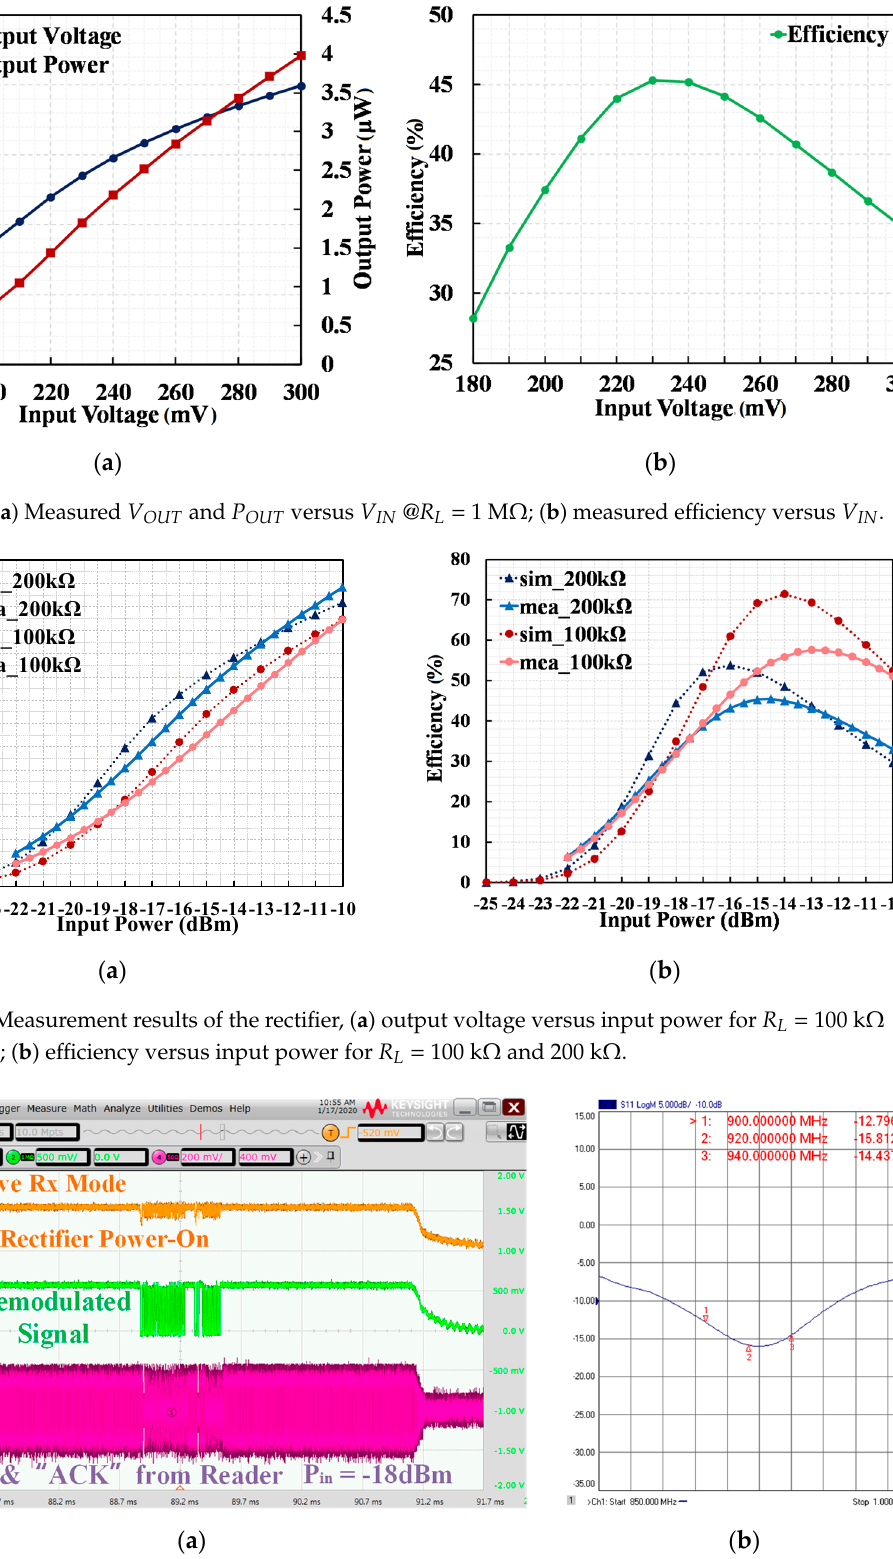
Figure 18. ( a ) Measured input signal and demodulated signal in low-power (LP) mode; ( b ) measured S11.